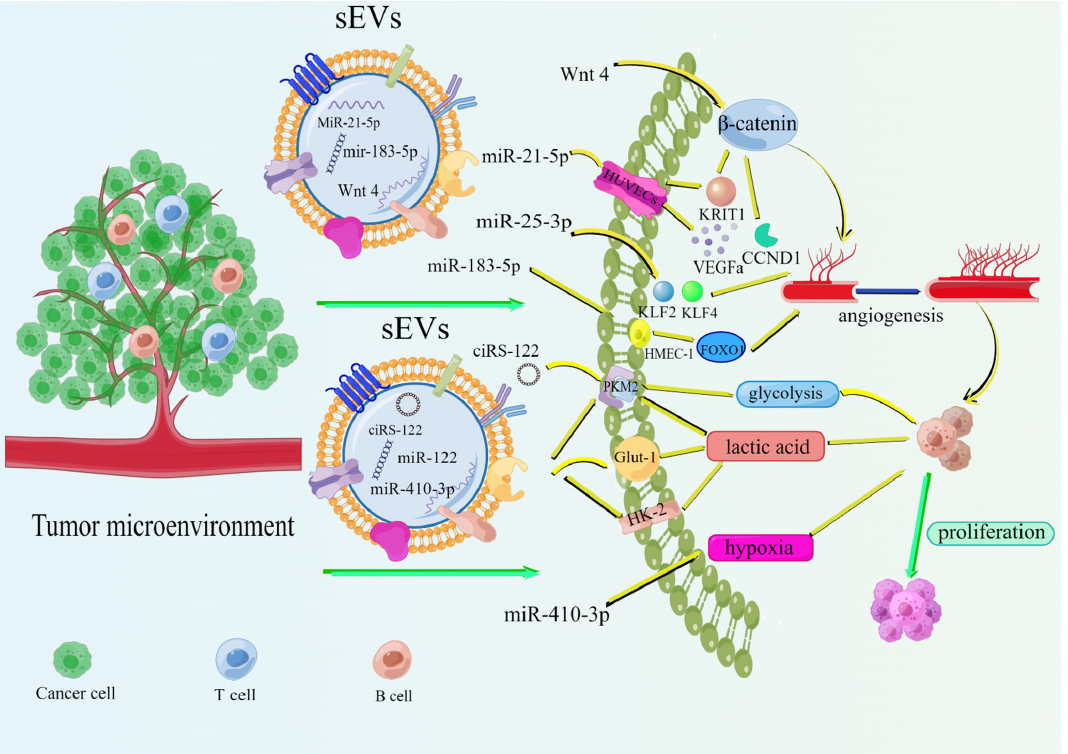
Figure 3. Mechanisms by which sEVs affect cell metabolism. When sEVs reach distant organs, Wnt 4 and three other miRNAs can promote angiogenesis by regulating proteins. Additionally, circ-IARS, the miRNA carried by CRC-derived sEVs, promotes the production of glucose lactate by up- regulating glut-1, HK-2, and PKM-2 levels. In addition, miR-410-3p can promote the formation of an anoxic microenvironment. Ultimately, these cells metabolize and promote tumor proliferation. Explanation: VEGF: Vascular endothelial growth factor, HUVECs: human umbilical vein endothe- lial cells. Besides tumor-cell-derived sEVs, M2 macrophage-derived sEVs and fibroblast-de- rived sEVs also play key roles in the development and metastasis of colorectal cancer. (1) M2 macrophage-derived sEVs can promote the development and metastasis of CRC cells in various ways, including remodeling the ECM and inducing the expression of immuno- phenotypic antigens in CRC cells. Cathepsin B, D, K, L, and S, as well as MMP-8, MMP- 12, MMP-13, and integrin β 1, α 4 are highly expressed on M2 macrophage-derived sEVs. These bioinformatic molecules play crucial roles in remodeling the TME, indirectly sug- gesting that M2 macrophage-derived sEVs play a key role in CRC remodeling [63]. M2 macrophage-derived sEVs can also promote CRC invasion by inducing the epithelial-to- mesenchymal transition (EMT) of CRC cells. M2 macrophage-derived sEVs with a high expression of glypican-1 can induce EMT in patients with CRC by suppressing E-cadherin expression and promoting the expression of vimentin and snail [64]. M2 macrophage-de- rived sEVs can promote EMT formation by activating the Wnt/ β -catenin axis. M2 macro- phage-derived sEVs carry CD14, CD68, MAC387, CD163, and DAP12 phenotypic anti- gens that can be detected in CRC. These immunophenotypic antigens promote the com- plete immune evasion of tumor cells [65]. Moreover, M2 macrophage-derived sEVs carry miRNAs (miR-21-5p and miR-155-5p) that promote CRC progression and invasion by